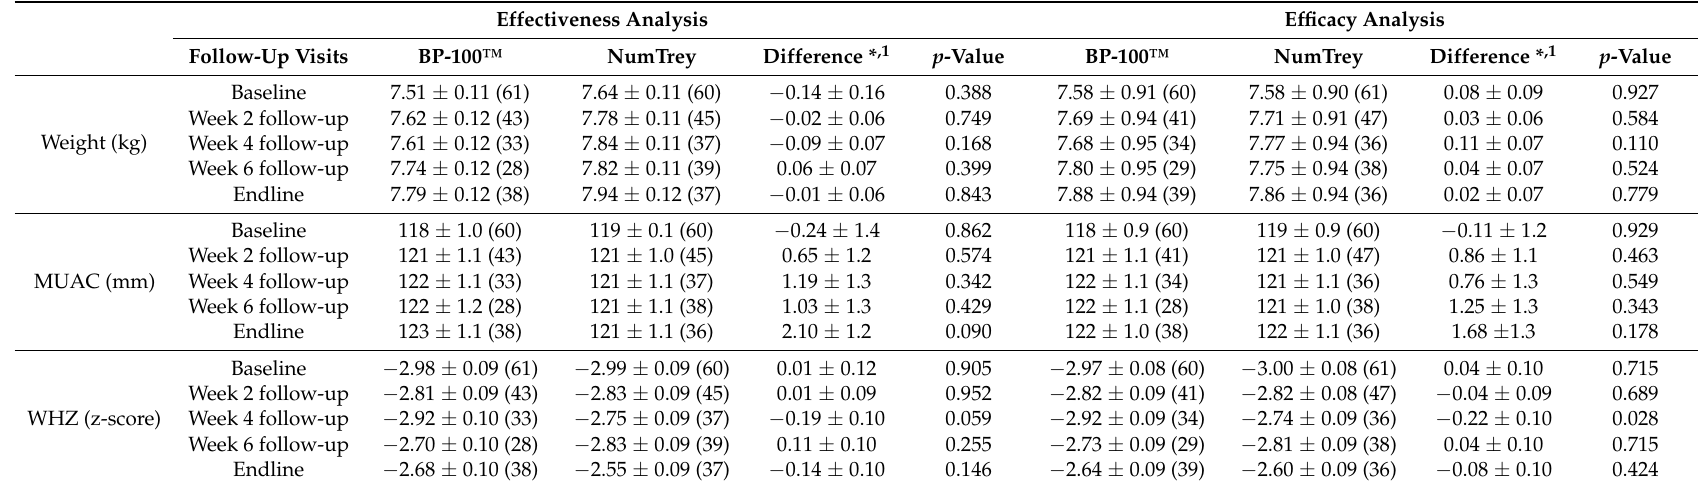
Table 4. Repeated measurement comparison between BP-100™ and NumTrey on anthropometric parameters using a linear mixed model adjusted for age, gender, and days in the effectiveness and efficacy